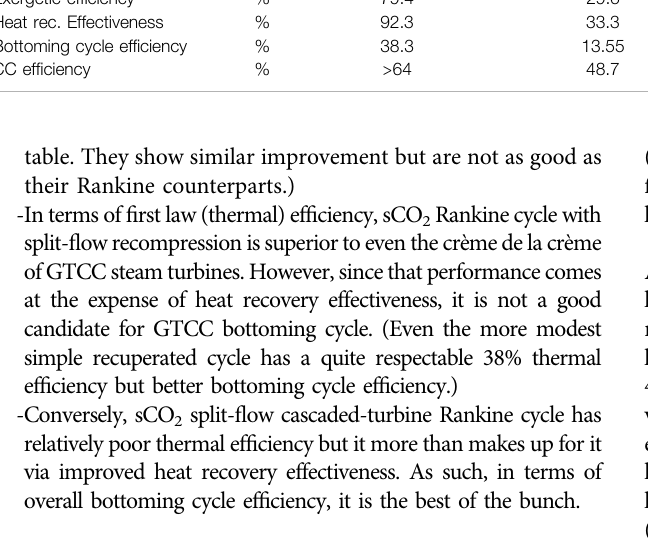
table. They show similar improvement but are not as good as their Rankine counterparts.)